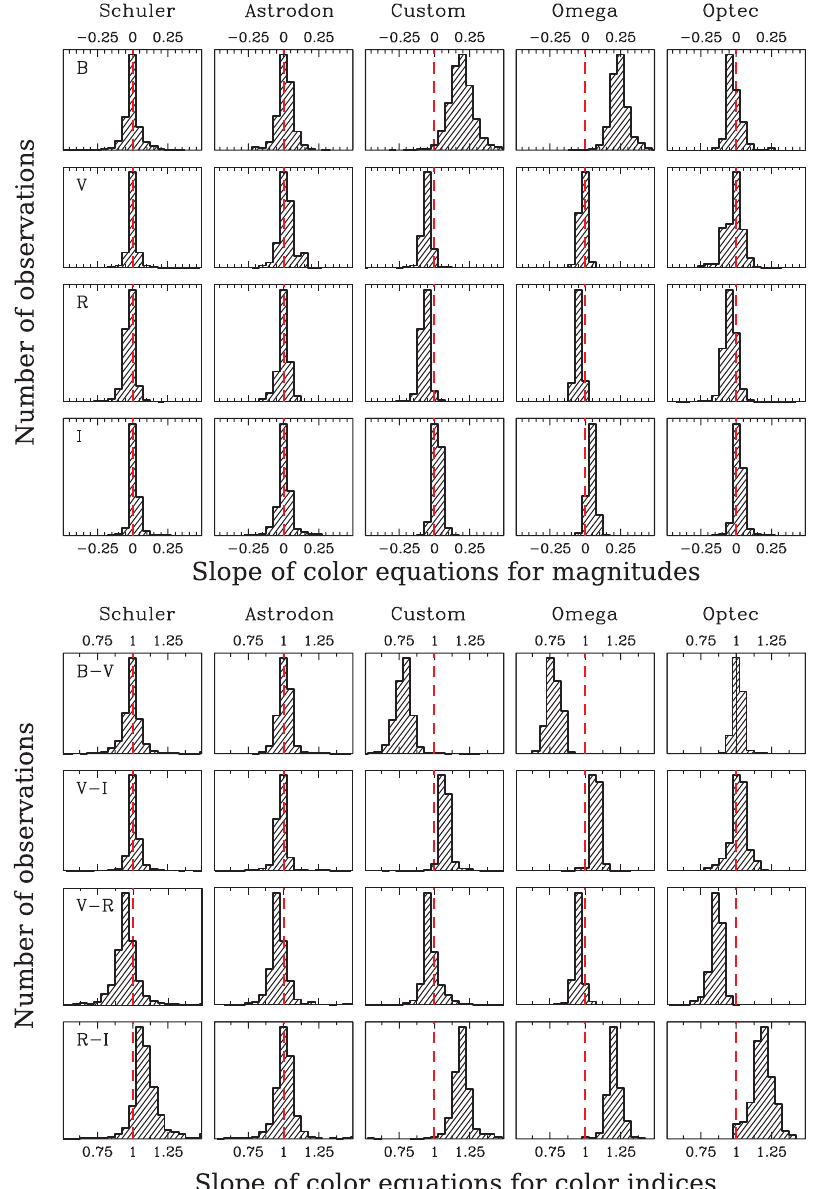
Fig. 3. Distribution of (cid:11) and (cid:12) values of Eq. (1) color-equations for 14602 BV R C I C measurements of symbiotic stars collected by the ANS Collaboration telescopes between 2005–2011. They are grouped according only to filter type, and include all measurements collected with that type of filter irrespective of the target star, telescope type, altitude, airmass, CCD type, sky condition, Moon phase,